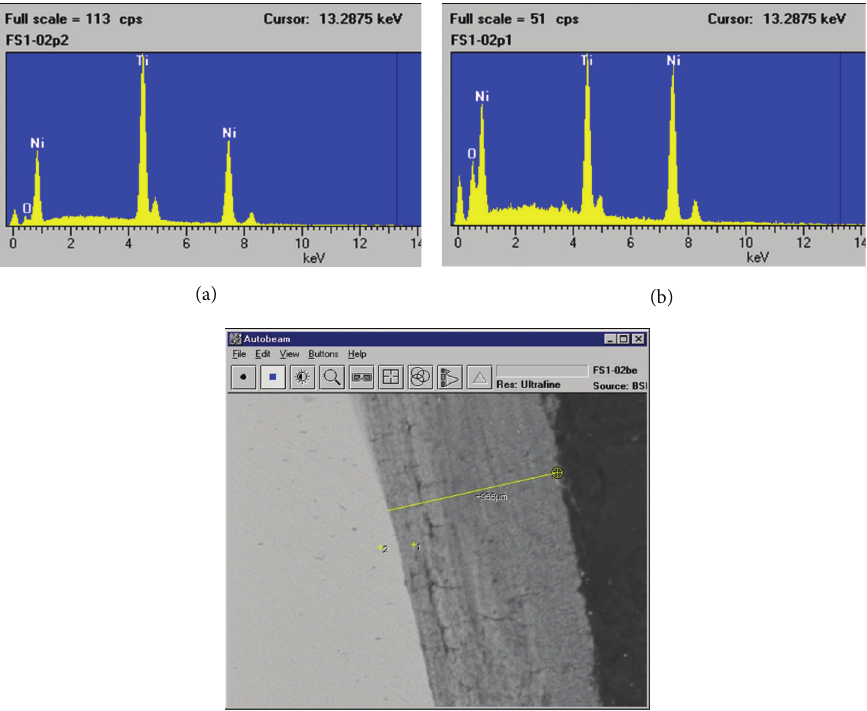
Figure 6: SEM view of a cut surface in NiTi with microanalysis. (a) EDS spectrum of bulk material; (b) EDS spectrum in the resolidified